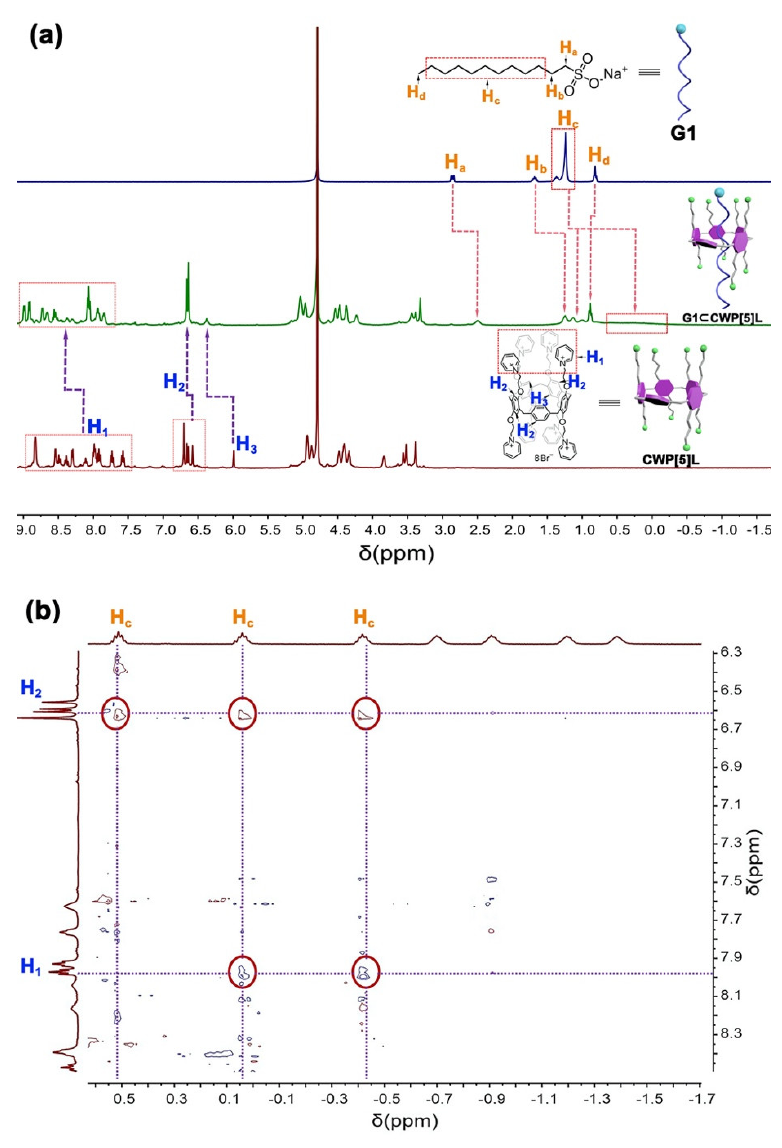
Figure 1. ( a ) 1 H NMR spectra (400 MHz, D 2 O, 298 K) of G1 , G1 + CWP[5]L and CWP[5]L . Concentrations of host and guest are all 4.0 mM; ( b ) 2D ROE analysis of CWP[5]L with G1 in D 2 O with a mixing time of 300 ms (600 MHz, 298 K; the concentrations of CWP[5]L and G1 are 4 mM and 5 mM, respectively).